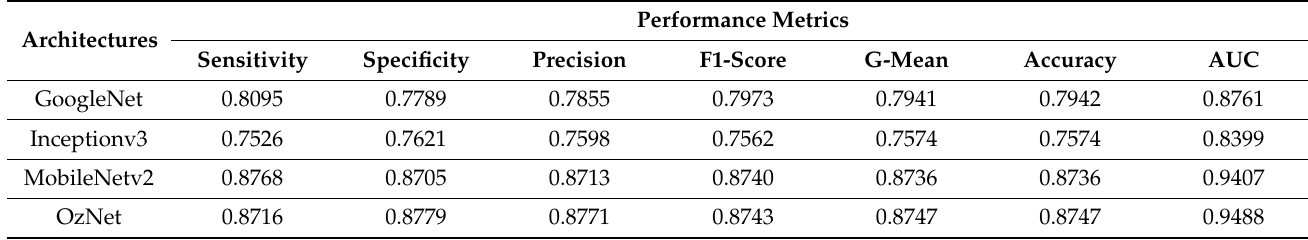
Table 3. Performance metrics of different architectures on Brain Stroke CT images.